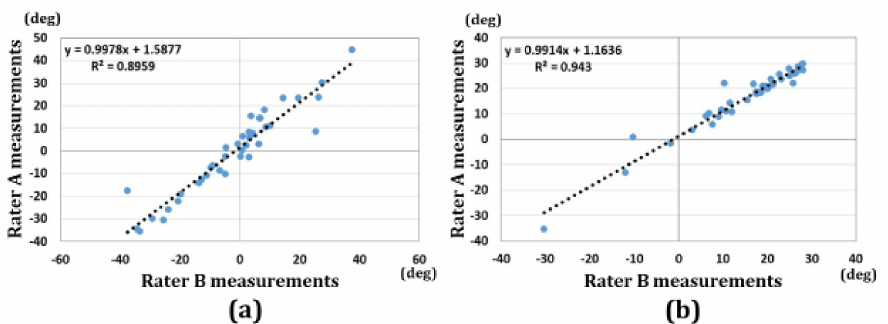
Figure 4. Results of correlations for the two rater measurements. ( a ) 3D-VT, ( b )